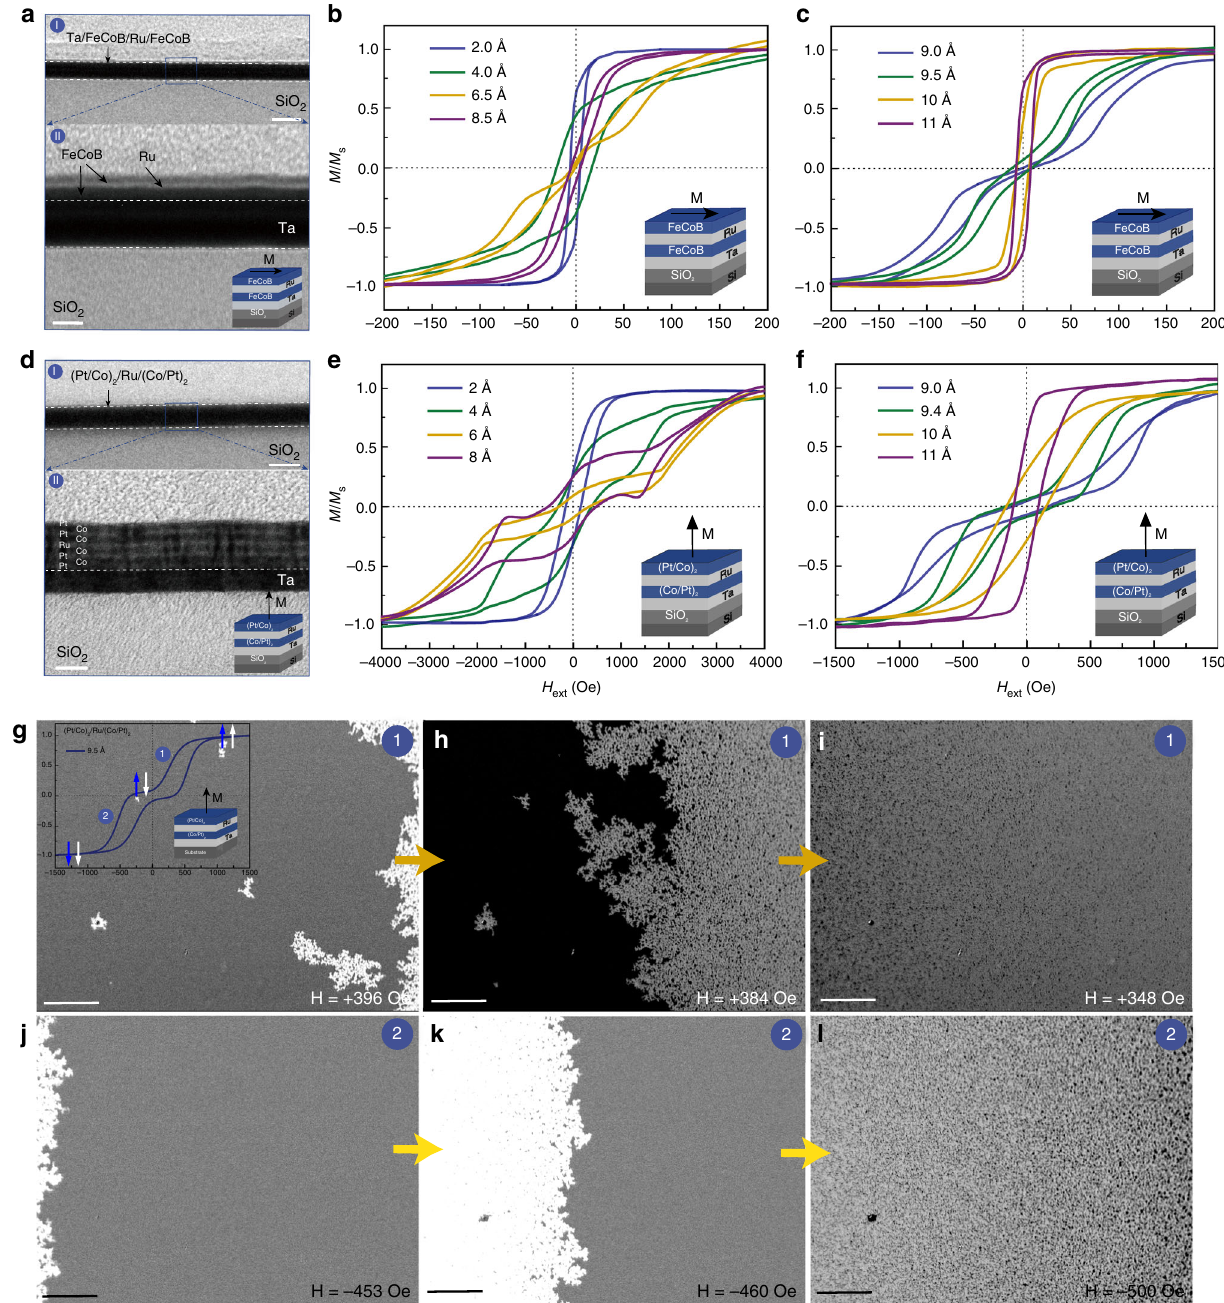
Fig. 1 Microstructure and magnetic properties. a Cross-sectional TEM images for FeCoB (1.5 nm)/Ru (0.95 nm)/FeCoB (1.5 nm)/Ta (7.5 nm)/SiO 2 /Si structure. II are partial enlarged images for I. Scale bar in I, 20 nm. Scale bar in II, 5 nm. b , c are magnetic hysteresis loops for in-plane FeCoB/Ru/FeCoB SAF heterostructures with different Ru thickness. d Cross-sectional TEM images for (Pt 9 Å/Co 7.5 Å) 2 /Ru (0.95 nm)/(Co 7.5 Å/Pt 9 Å) 2 /Ta (3.5 nm)/ SiO 2 /Si structure. II are partial enlarged images for I. Scale bar in I, 50 nm. Scale bar in II, 5 nm. e , f are Ru thickness dependence of magnetic hysteresis loops for out-of-plane (Pt/Co) 2 /Ru/(Co/Pt) 2 SAF heterostructures. g – l Perpendicular dynamic magnetization reversal for (Pt 9 Å/Co 7.5 Å) 2 /Ru (0.95 nm)/(Co 7.5 Å/Pt 9 Å) 2 /Ta (3.5 nm) structure observed in polar MOKE mode. Scale bar, 50 μ m. Figure ( g – i ) marked by 1 are the images when H- fi eld decreases from + 1000 to + 0 Oe. Figure ( j – l ) marked by 2 are the images when H- fi eld decreases from + 0 to − 1000 control effect of SAFs with PMA based on (Pt/Co) 2 /Ru/(Co/Pt) 2 of (Pt/Co) 2 /Ru/(Co/Pt) 2 multilayers. The fi rst AFM coupling structures. Figure 1d shows the TEM result of Co/Pt composites interval is 0.4 to 1 nm, while the second oscillatory area for AFM (with PMA). The layered structure of Pt/Co/Pt/Co/Ru/Co/Pt/Co/ coupling is around 2 nm (since fi lms less than 1 nm are more Pt/Ta from top-to-bottom is clearly identi fi ed in the enlarged effective for IL-gating-control, 2 nm data are not shown here). pictures (Fig. 1d II); this is crucial for both RKKY interaction and This perpendicular SAF con fi guration has PMA and IEC at the PMA exhibition. Supplementary Fig. 1 shows the polycrystalline same time, making it different from a pure in-plane SAF structure of Co/Pt system. Figure 1e, f display the t Ru dependence structure. The PMA depends on Co 3d – Pt 5d interfacial